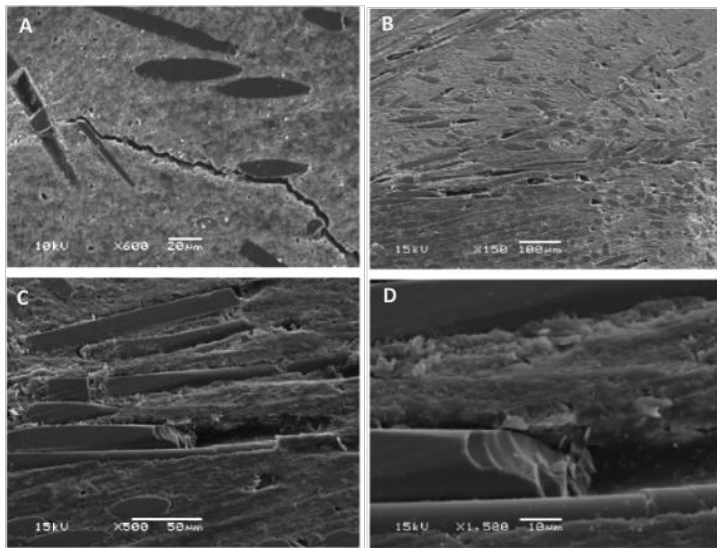
Figure 4. SEM micrographs of ( A ) a polished surface of a fiber composite with a propagating crack and ( B – D ) fracture surfaces with different magnifications showing fractured glass fibers Images from [65].